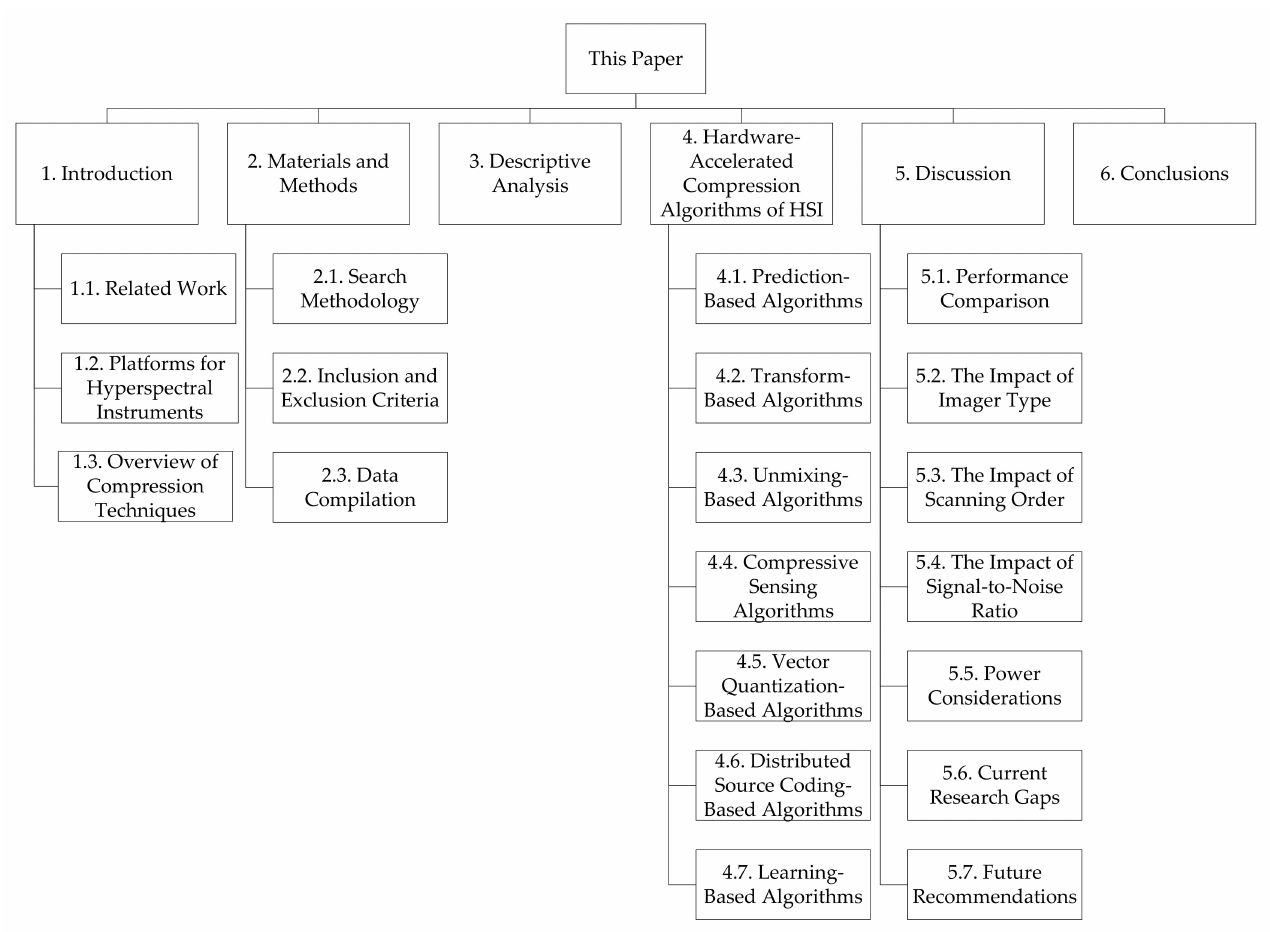
Figure 2. Organization of this article as a tree structure to help readers navigate through its different